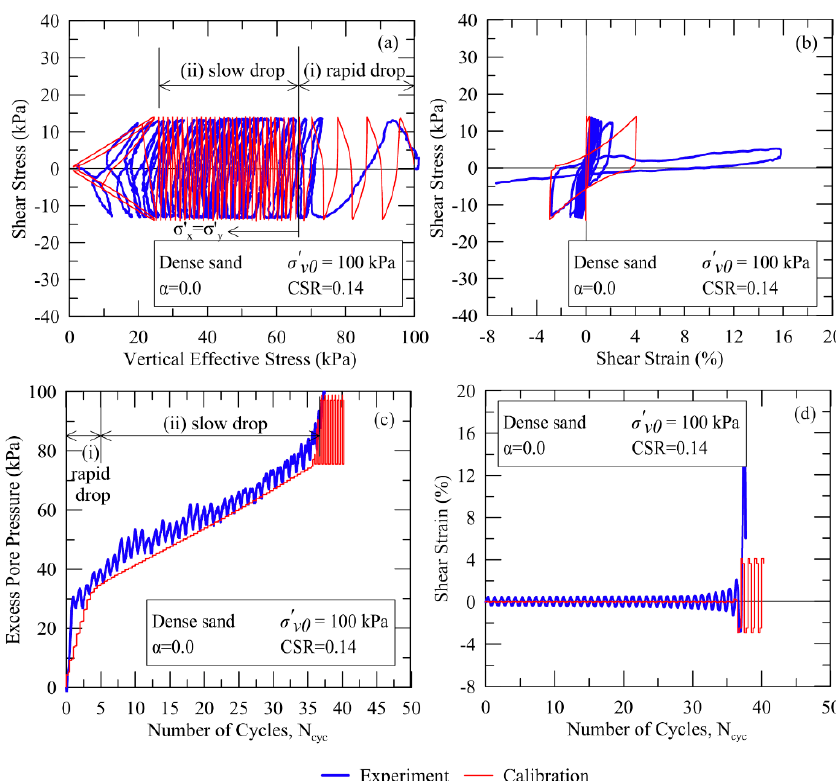
Figure 6. Comparison of the UBCSAND2 model for dense Pohang sand and laboratory CDSS test at CSR = 0.14, σ ´ v0 = 100 kPa, and α = 0.0 in the variations of (a) stress path, (b) shear stress–strain curve, (c) excess pore water pressure generation, (d) shear strain and number of cycles to liquefaction.